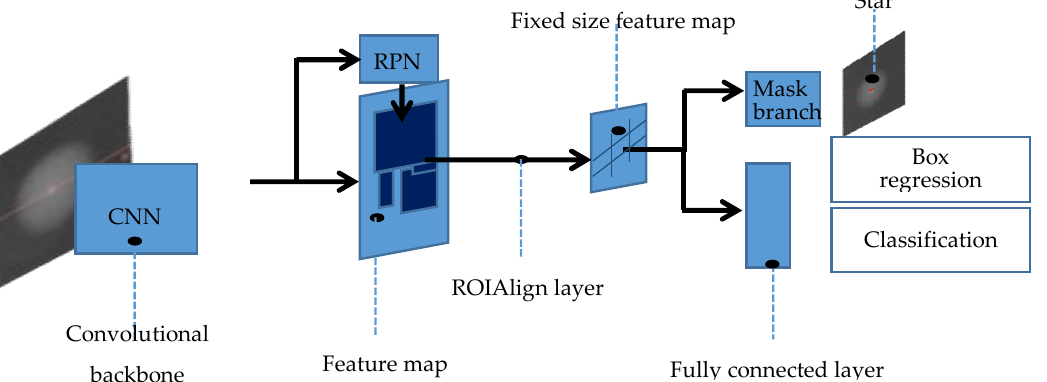
Figure 2. Mask R-CNN flow chart. CNN: convolutional neural network; ROI: region of interest; RPN: region proposal network.